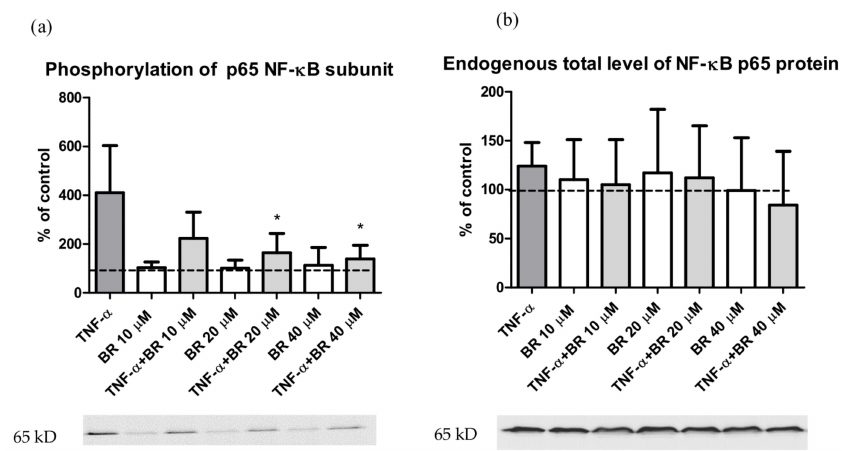
Figure 6. The e ff ect of bilirubin on NF- κ B p65 subunit phosphorylation. Both types of primary hepatocytes were pre-incubated with BR (0–40 µ M) for 2 h and then treated with TNF- α (12 ng / mL) for 5 min. Phosphorylated ( a ) and total ( b ) NF- κ B p65 subunits were measured by the western blot. Values are expressed as % of untreated control cells (100%). * p < 0.05 vs. TNF- α . n = 6 independent cell cultures per